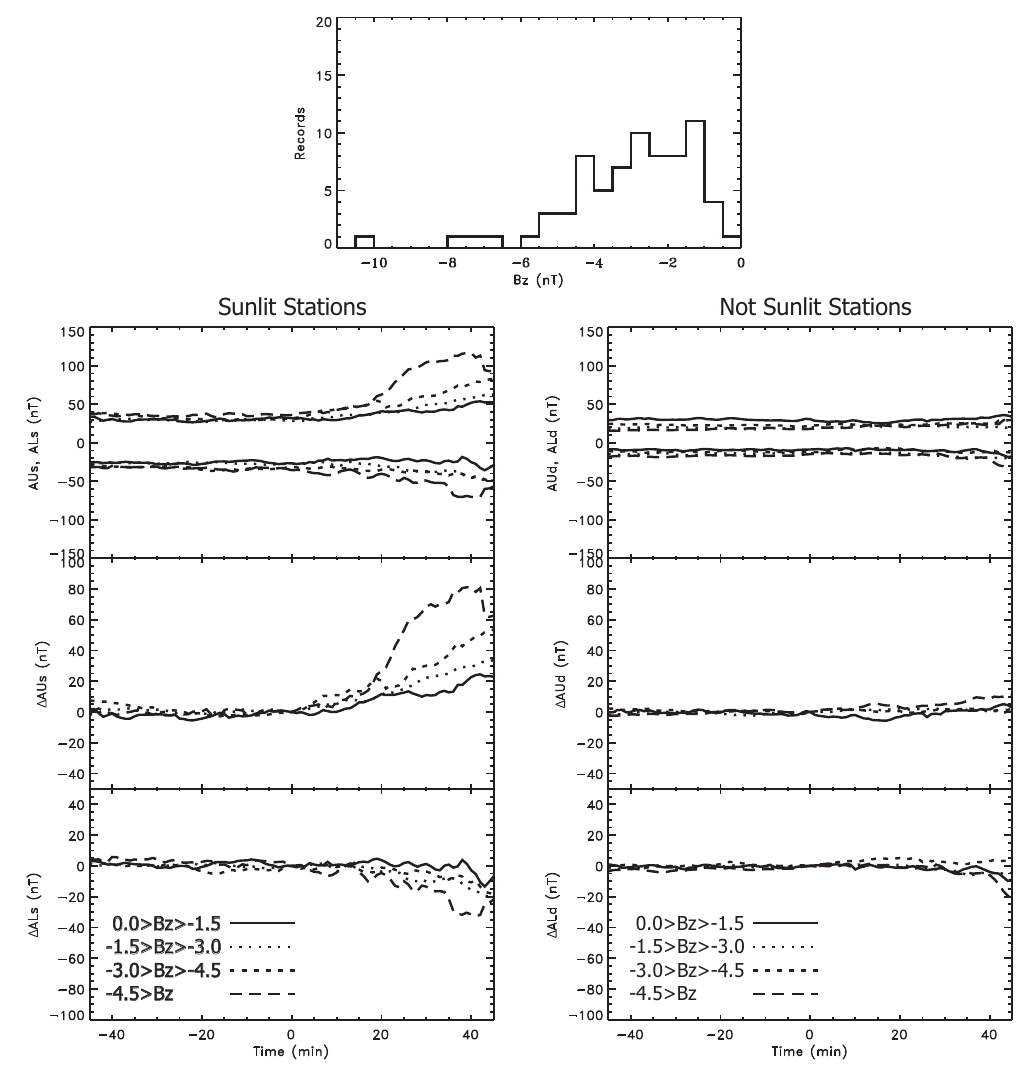
Fig. 6. Distribution of the median IMF B z during the pre-unloading phase after the southward turning (top panel). Left column shows AUs/ALs for four intervals of B z (top panel) and change in AUs/ALs from time of southward turning (bottom two panels). Right column has same format as left column but for nightside